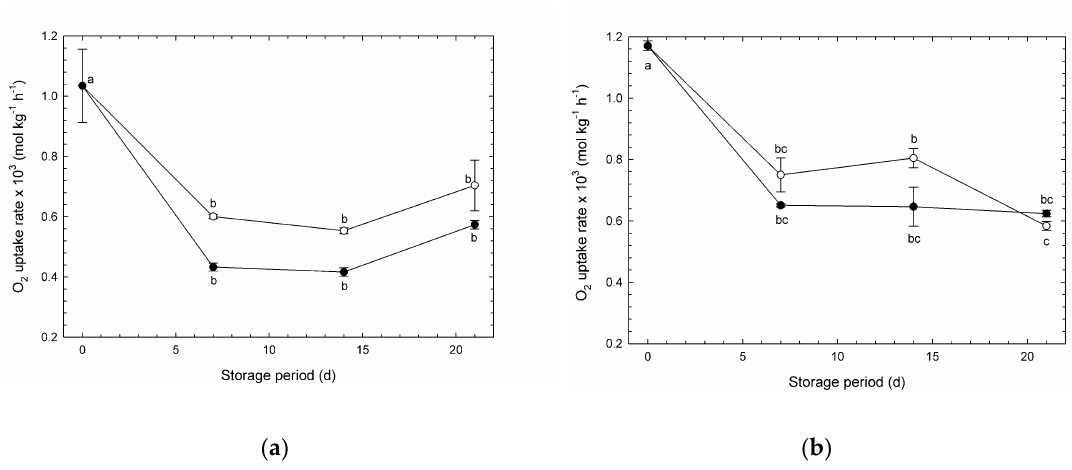
Figure 2. O 2 uptake rates of broccoli heads during storage at 1 °C. ( a ) Experiment #1: , normoxia; , O 2 / CO 2 = 2.5% / 6.0% ( + N 2 to 100%). ( b ) Experiment #2: , normoxia; , O 2 /CO 2 = 2.5%/0.0% (+ N 2 to 100%). Values are means ± SE of three biological replicates. Significant differences ( p < 0.05) are denoted by different letters.